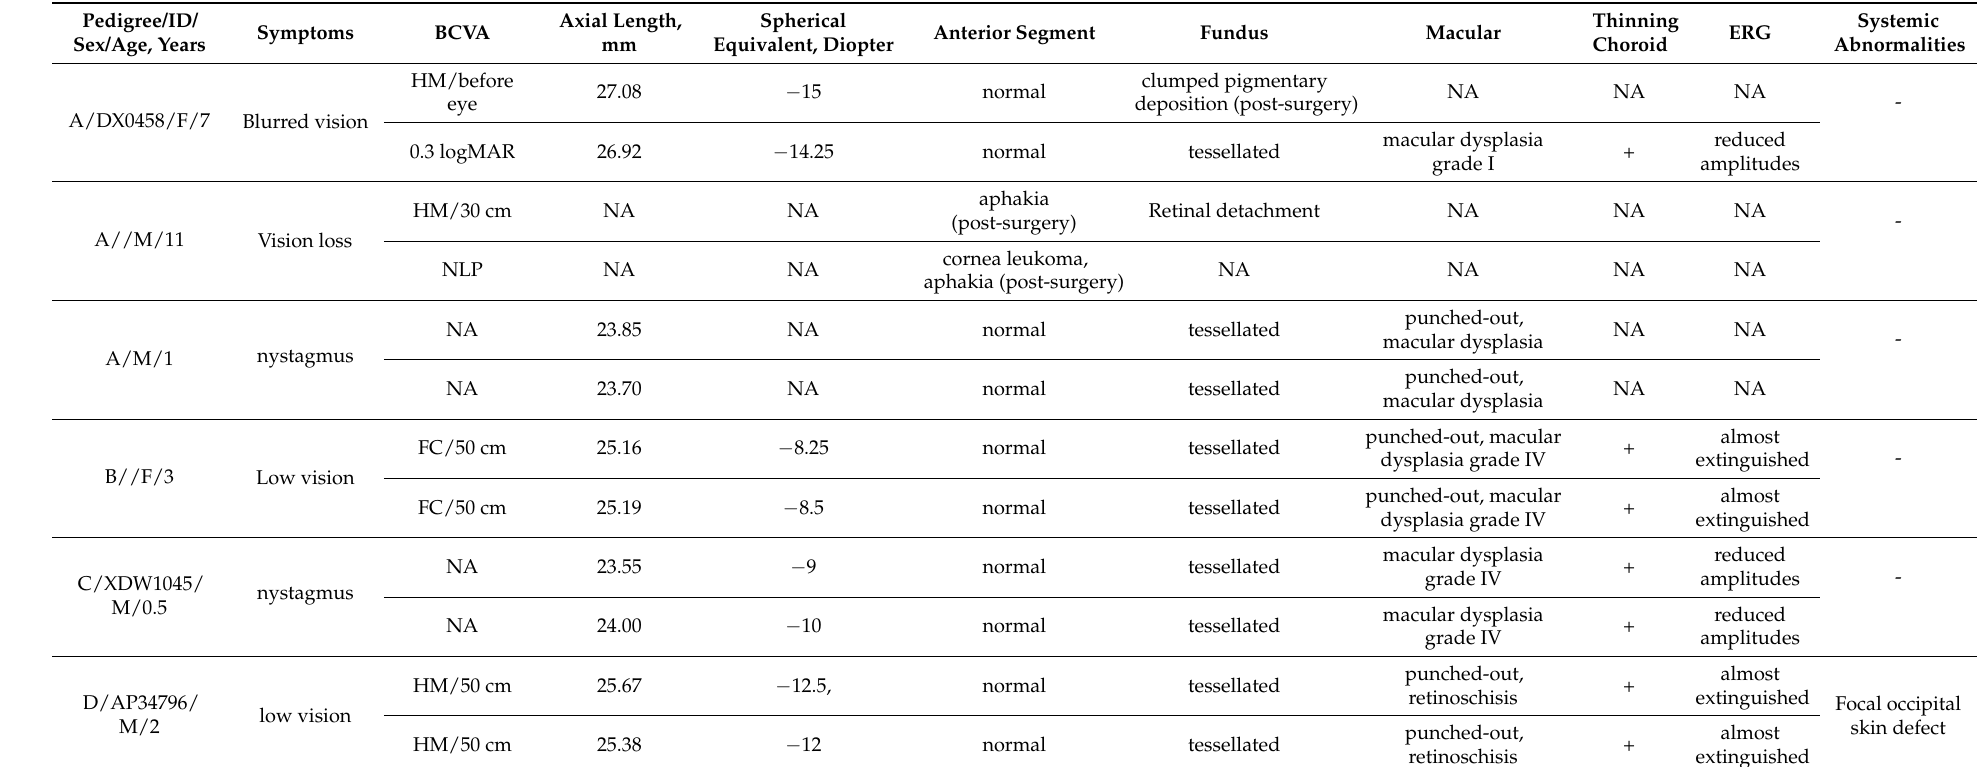
Table 1. Clinical features of the KS